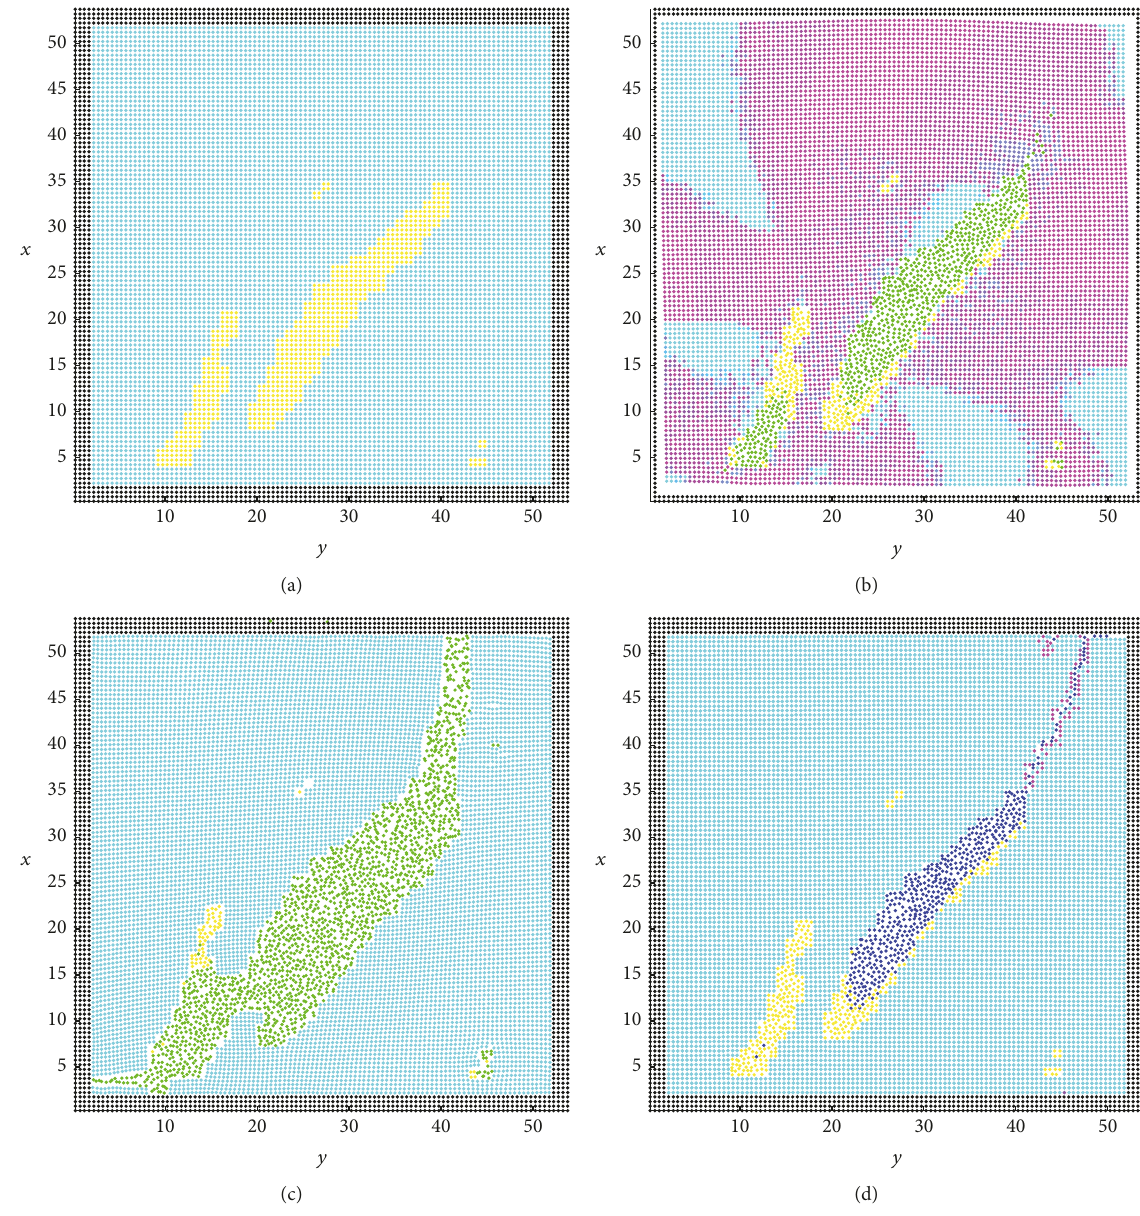
Figure 14: A cross-section (SPH points inside the 58ℎ < 𝑧 < 59ℎ range) of the unit cell. Color notation is the same as for previous figure showing a cross-section. Images correspond to (a) Initial sample surface, 𝑡 = 0s. (b) No confining stress is applied. 𝑡 = 4s. (c) Constant volume boundary conditions. No damage model is applied, and the 𝑅 𝑝 = 0.375 . Time 𝑡 = 3.6 s. (d) Constant volume boundary conditions. Damaged particles are considered as ghost particles which do not interact with any other particles. Blue particles correspond to gas phase. 𝑡 = 6.8